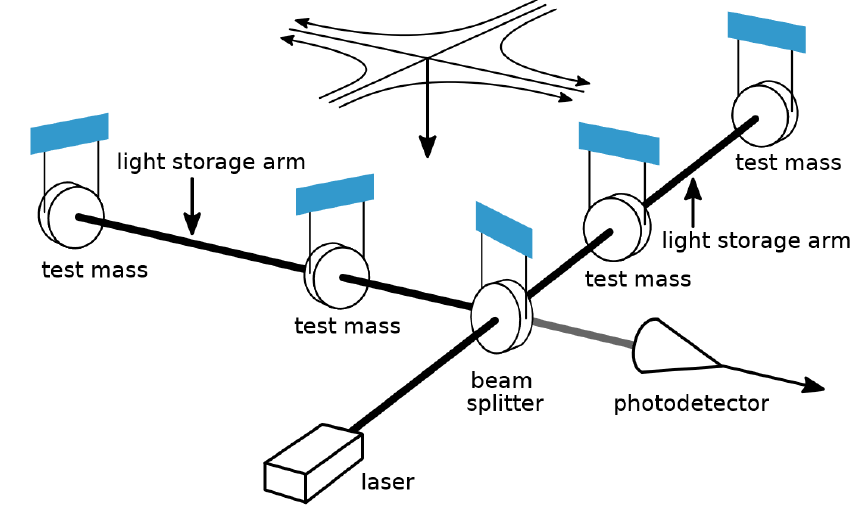
Figure 2. This is a schematic diagram of the Michaelson interferometer. A monochromatic laser light is split into two beams by the beam splitter which travel along the two perpendicular arms. The laser light moves back and forth in the two arms between the two mirrors depicted as test masses in the figure and is then made to combine again to form an interference pattern. A gravitational wave passing through the interferometer in the direction perpendicular to its plane for instance, will change the length of one arm with respect to another, causing relative phase shift of the laser light, resulting into the shift in the interference pattern. (Image credit: the Laser Interferometer Gravitational Wave Observatory